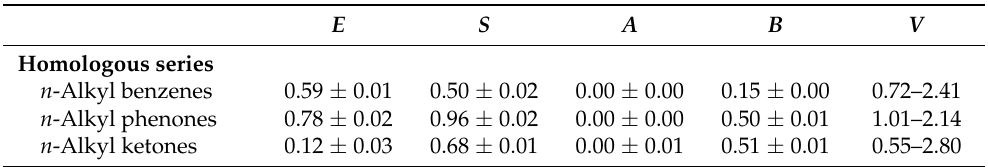
Table 1. Molecular descriptors of the homologous series (mean values for E , S , A , and B ; ± standard deviation; range for V ) considered in this work [39].